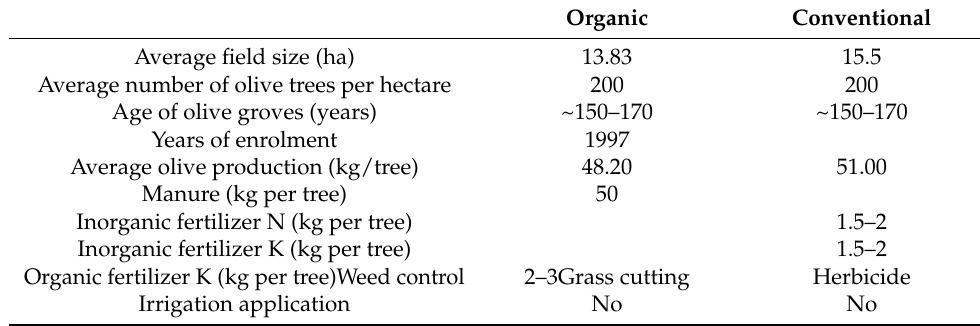
Table 1. General characteristics and applied management practices to the organic and conventional olive groves (Amfissa variety) in central